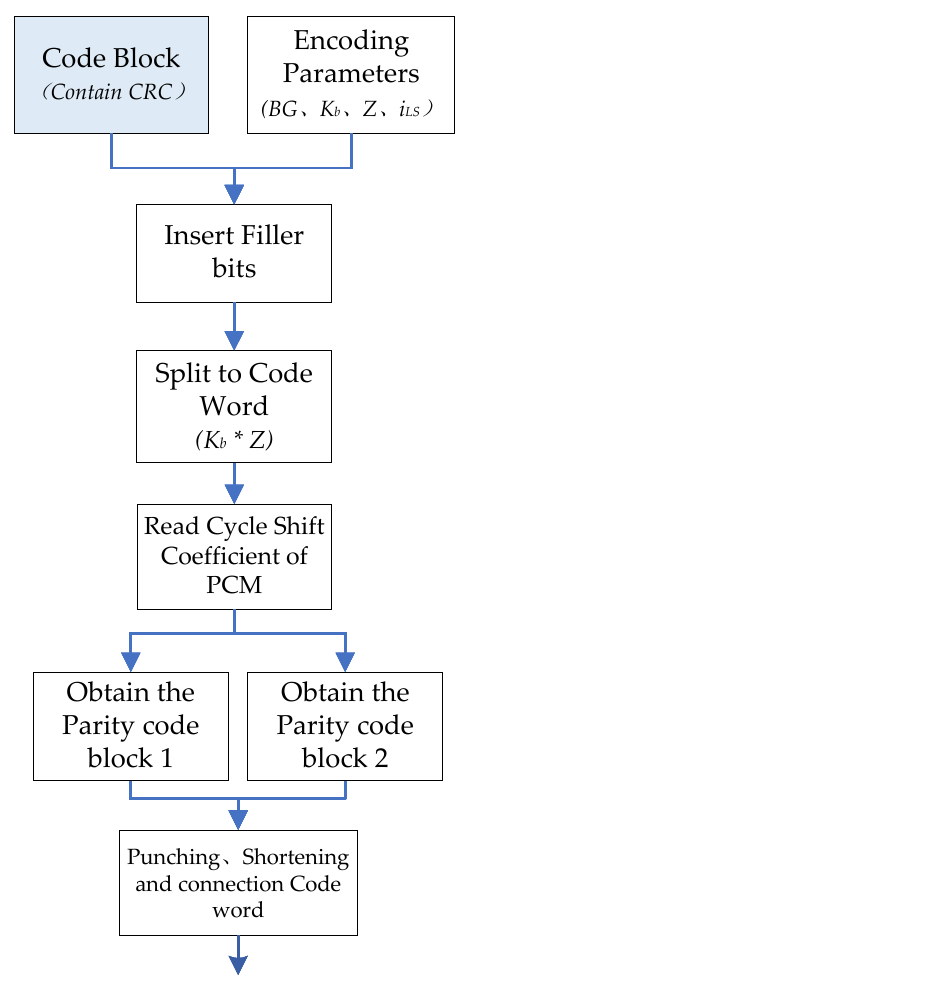
Figure 2. 5G QC-LDPC encoding process.